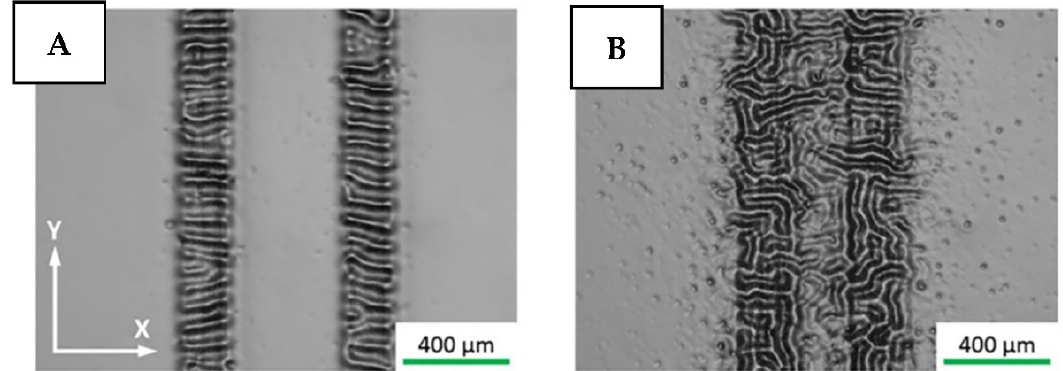
Figure 12. Optical microscopy images of spatially selective and reversible surface pattering by electrode printing—impact of the distance between two electrode lines: ( A ) 400 mm, and ( B ) 200 mm. Reprinted with permission from ref. [148]. Copyright 2020 Elsevier.